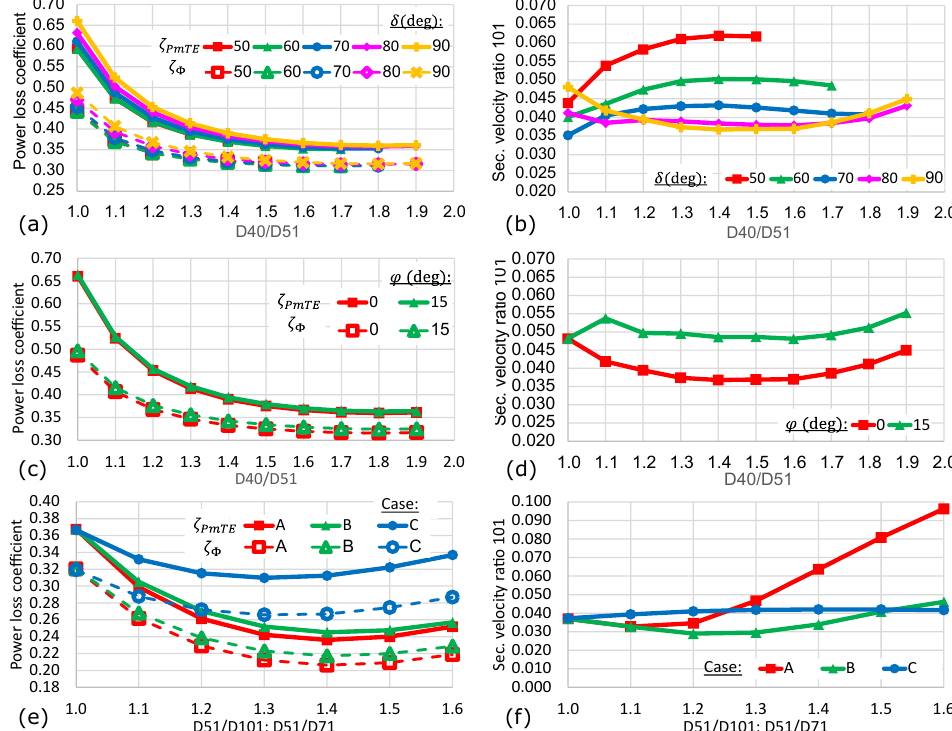
Figure 7. Line plots of the power loss coefficients and secondary velocity ratios of the basic model with conical frustum. Charts ( a , b ) show the effect of a variation of the diameter ratio D 40 / D 51 of the frustum for different deviation angles δ . Charts ( c , d ) show the effect of a variation of the same diameter ratio for a horizontal pivot angle ϕ = 15 ◦ . Charts ( e , f ) show the effect of a variation of the diameter ratios D 51 / D 101 and D 51 / D 71 for converging pipe bend sections 61–71 (configuration C) and 81–91 (configurations A,